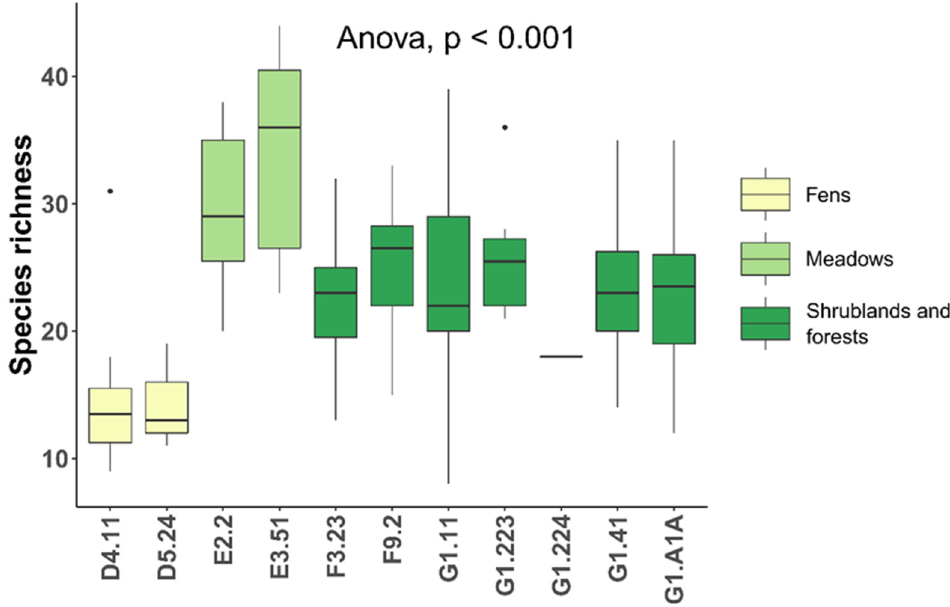
Figure 2. Species richness in habitat types and ANOVA resulting p -value. The color scale identifies the 3 groups with significant differences resulting from ANOVA post-hoc analysis ( α < 0.05): fens (light yellow), meadows (light green) and shrublands and forests (green).